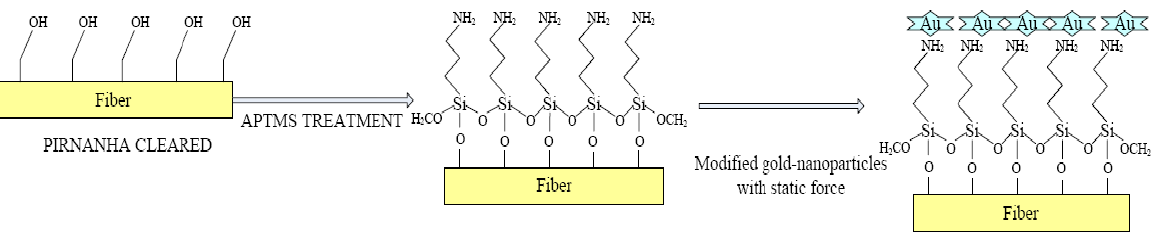
Figure 3. Schematic of self-assembly of gold nanoparticles in